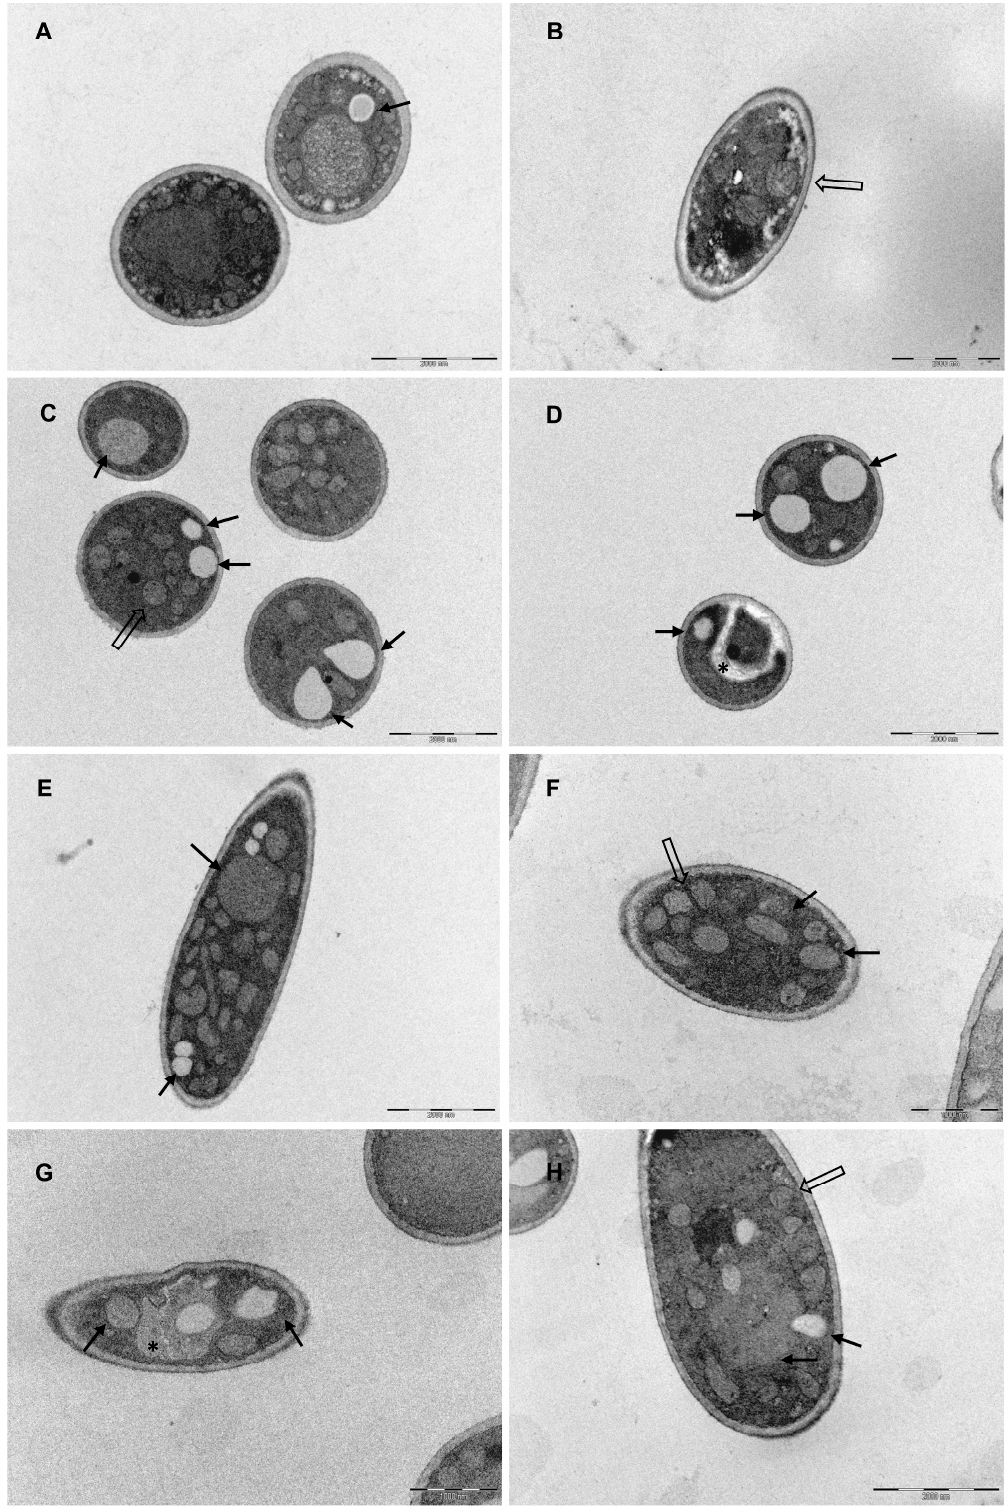
Figure 5. Transmission electron microscopic observations of T. rubrum . ( A , B ) Non-treated fungal cells, scale bar: 2000 nm; ( C – E ) treated with caffeinated SCG extract (137.5 µg/mL), scale bar: 2000 nm; ( F – H ) treated with decaffeinated SCG extract (150 µg/mL), ( F , E ) scale bar: 1000 nm, ( H ) scale bar 2000 nm*—autophagic-like structures; black arrow—vacuoles; open arrows—mitochondria.